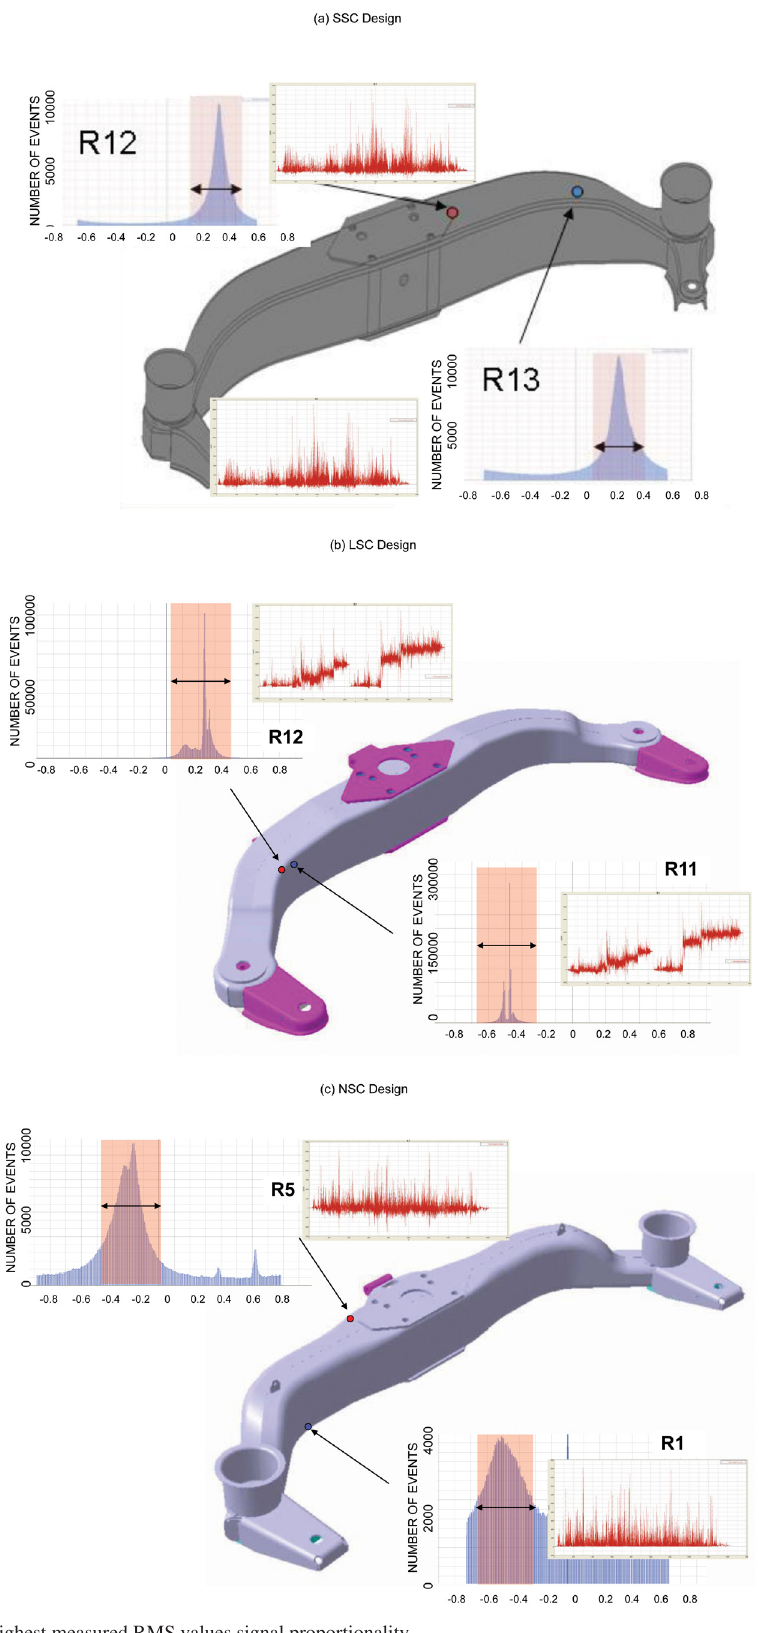
Figure 3. Designs highest measured RMS values signal